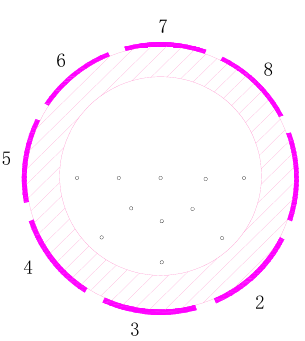
Figure 4. Distribution of the charged particles in the cross section of the pipe.